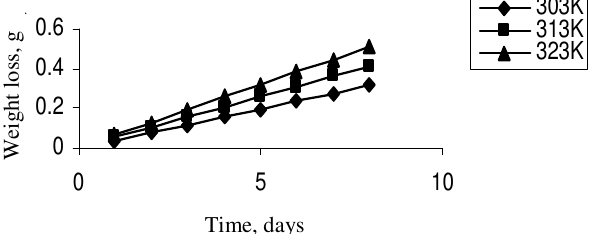
Figure 3. Variation of weight loss (g) with time (days) for mild steel coupons in 2 M HCl solutions at different temperatures without inhibitor.